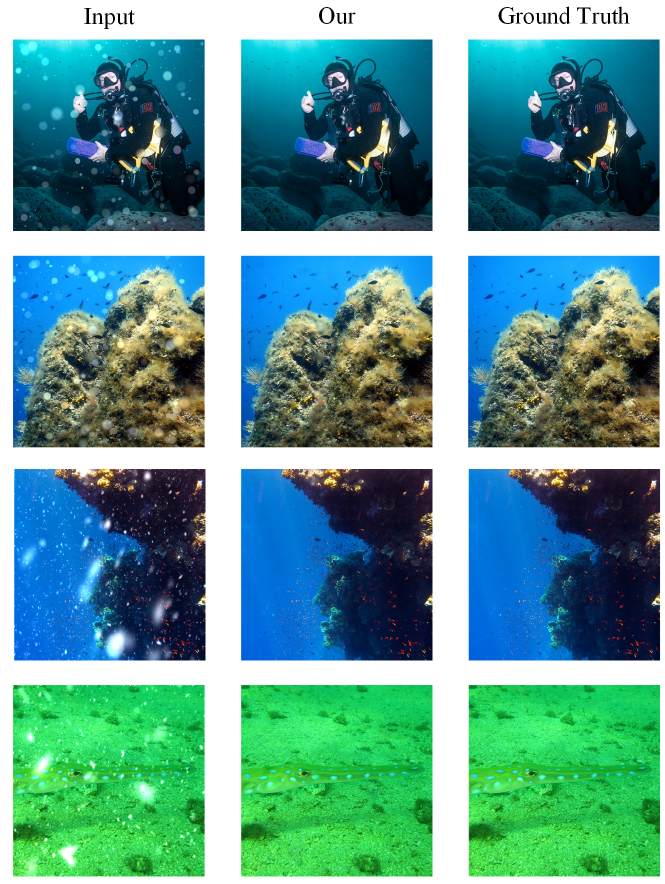
Figure 5. Image restoration results of UIR-Net on MSRB and MSIRB datasets.